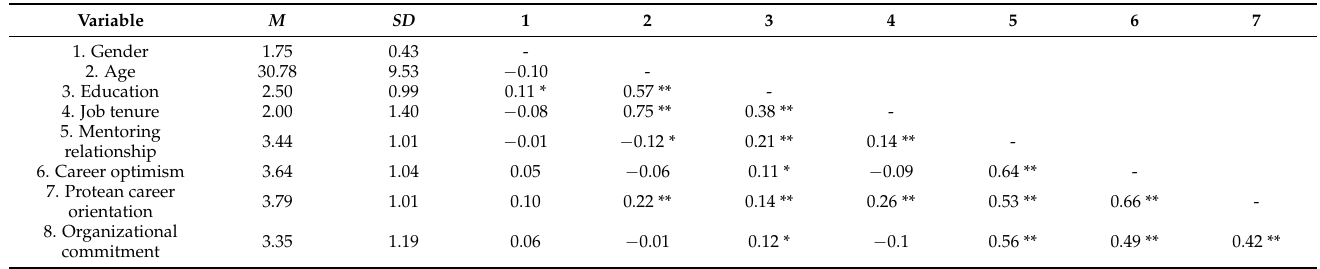
Table 2. Mean, standard deviation and correlation coefficient of variables.